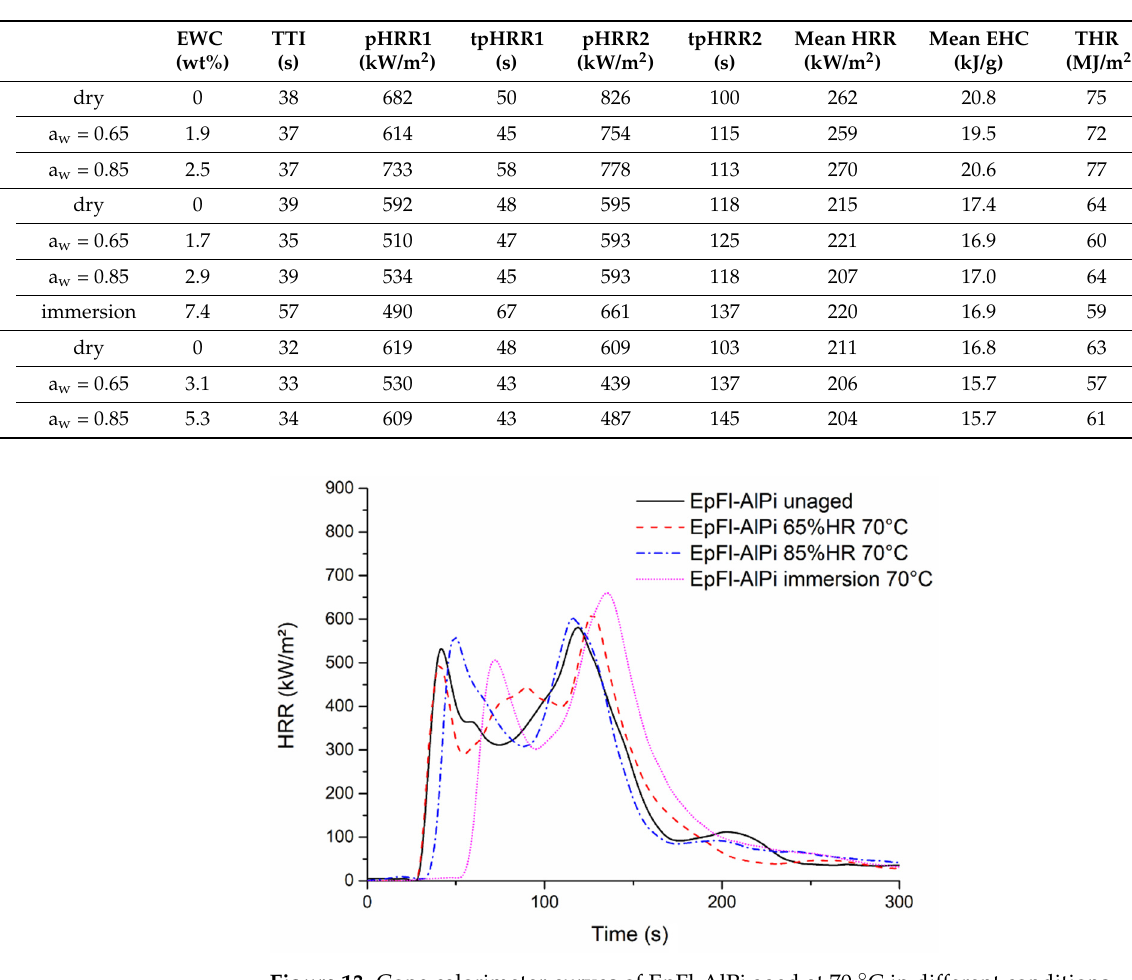
Table 3. Cone calorimeter data for the various composites after ageing.